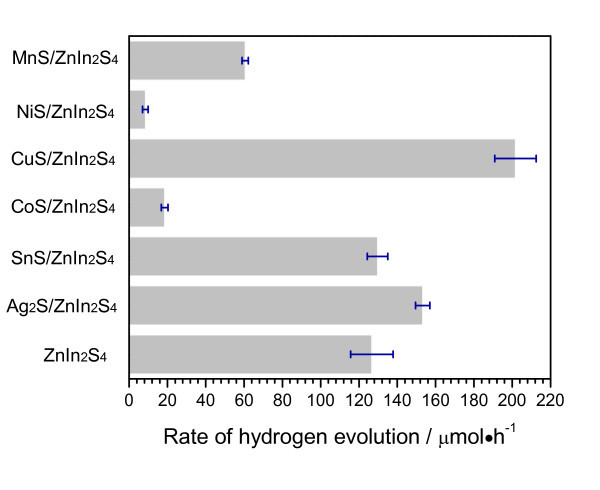
Average rates of H2 evolution. The average rates of H2 evolution over Pt-loaded MS/ZnIn2S4 (MS = metal sulfide: Ag2S, SnS, CoS, CuS, NiS, and MnS) under solar light irradiation in the initial 20-h period.